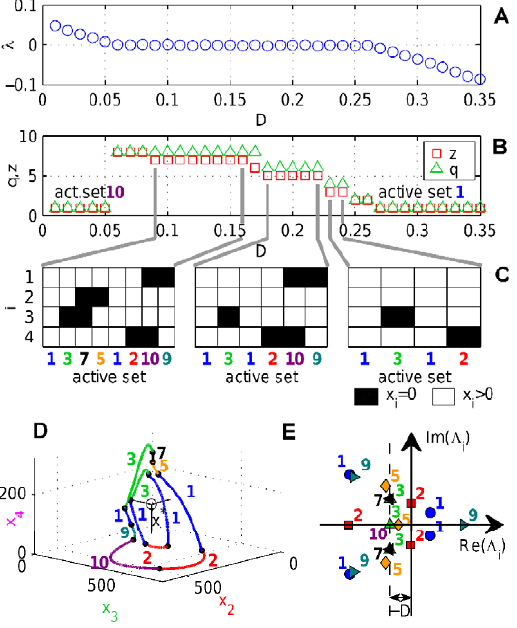
Figure 3. The edge of chaos. The Lyapunov exponent l of the four node system, Eq. (8), is shown in (a) as a function of the decay rate D , which exhibits a ‘‘plateau’’ with l ~ 0 in the range 0 : 06 v D v 0 : 26 . In (b) the length q of the periodic sequence of domains is plotted in green triangles and the number of different active sets z as red squares. In (c) the sequences of active sets are shown for decay rates D ~ 0 : 23 , ~ 0 : 2 and 0 : 14 . The limit circles for decay rates D ~ 0 : 23 (short sequence) and D ~ 0 : 14 (long sequence) are visualized in (d) in a Poincare map using three out of four phase-space dimensions. With decreasing D the radius of the limit circle becomes wider and additional sets (marked with colors) become active. In (e) the spectra of eigenvalues are shown for all the appearing active sets with D ~ 0 : 14